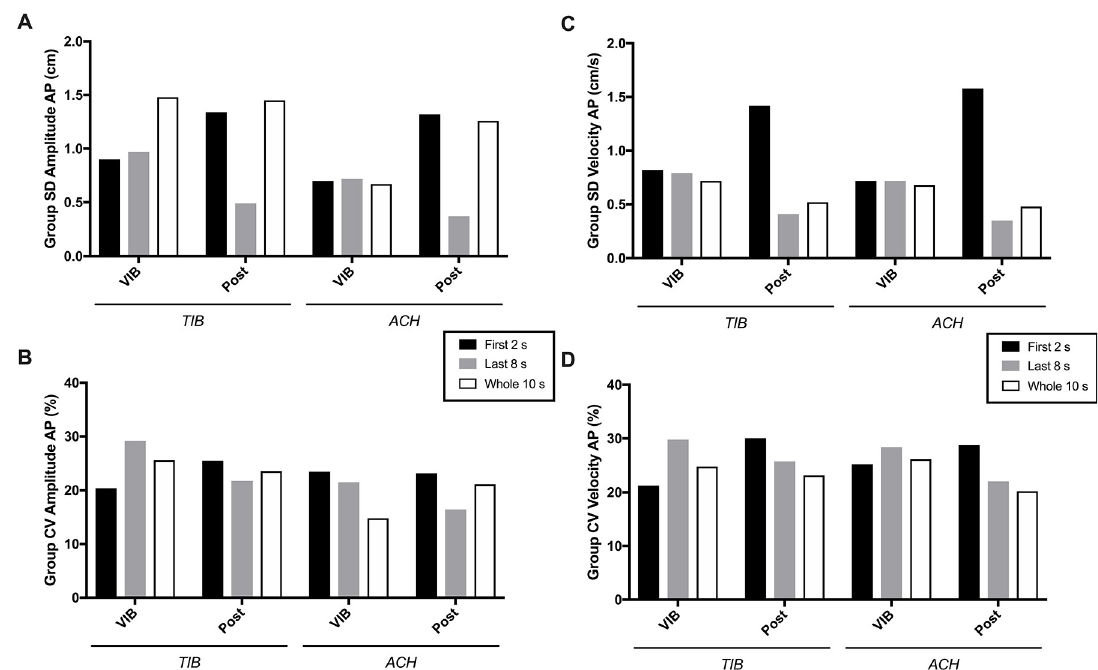
Fig 4. Inter-individual (group) variability of Amplitude (A & B) and Velocity (C & D) center of pressure variables for the three time-windows analyzed. Variability is estimated by the standard deviation (SD) and coefficient of variation (CV = SD in percentage of the mean). AP = anteroposterior axis; VIB & POST = vibration and post-vibration periods; TIB & ACH = tibialis anterior & Achilles’